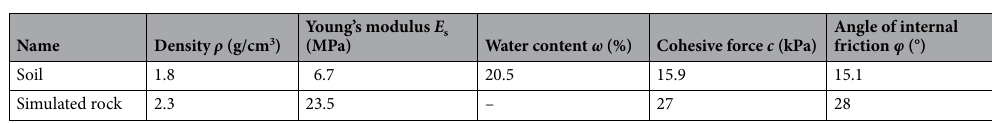
Table 6. Physical properties of soil and simulated